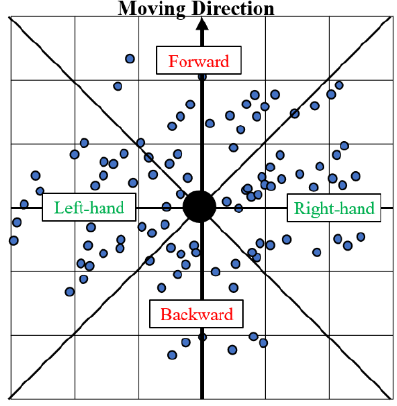
Figure 4 . Schematic graph of point cloud distribution analysis.